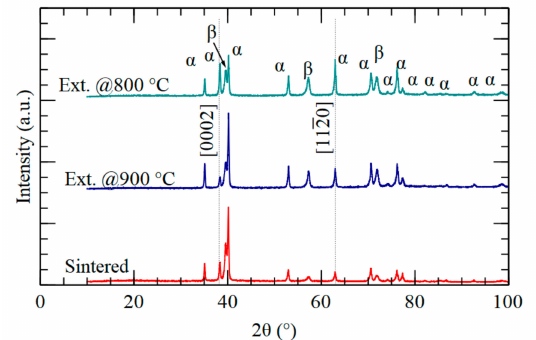
Figure 2. XRD patterns of the sintered and extruded PM Ti-5Fe alloys.